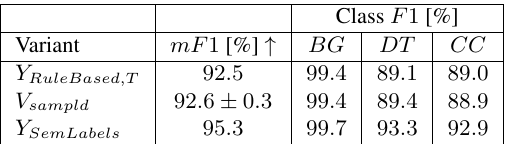
Table 5. Agreement of different label maps for the test area with the manually generated reference Y Manual